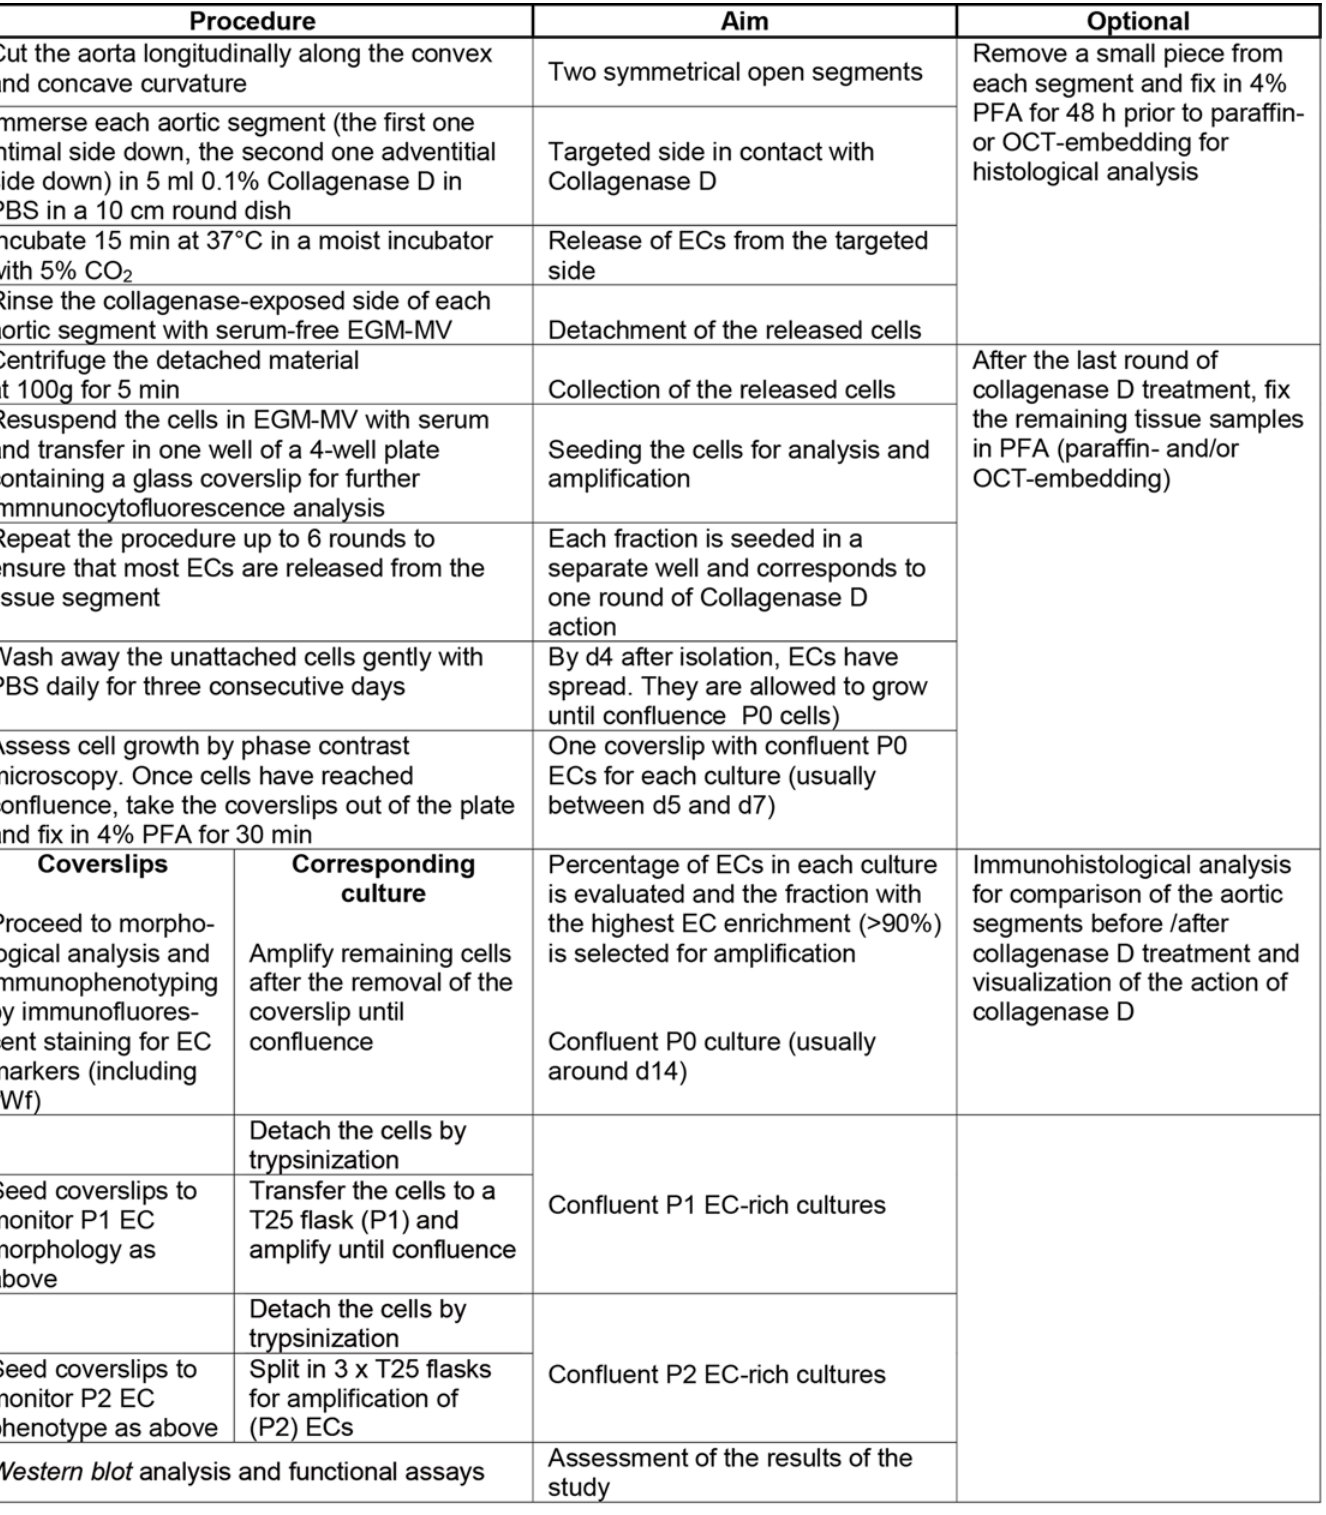
Fig 6. Procedure flow chart for the simultaneous isolation of ECs from the intima and adventitia of human aortic vessel segments.